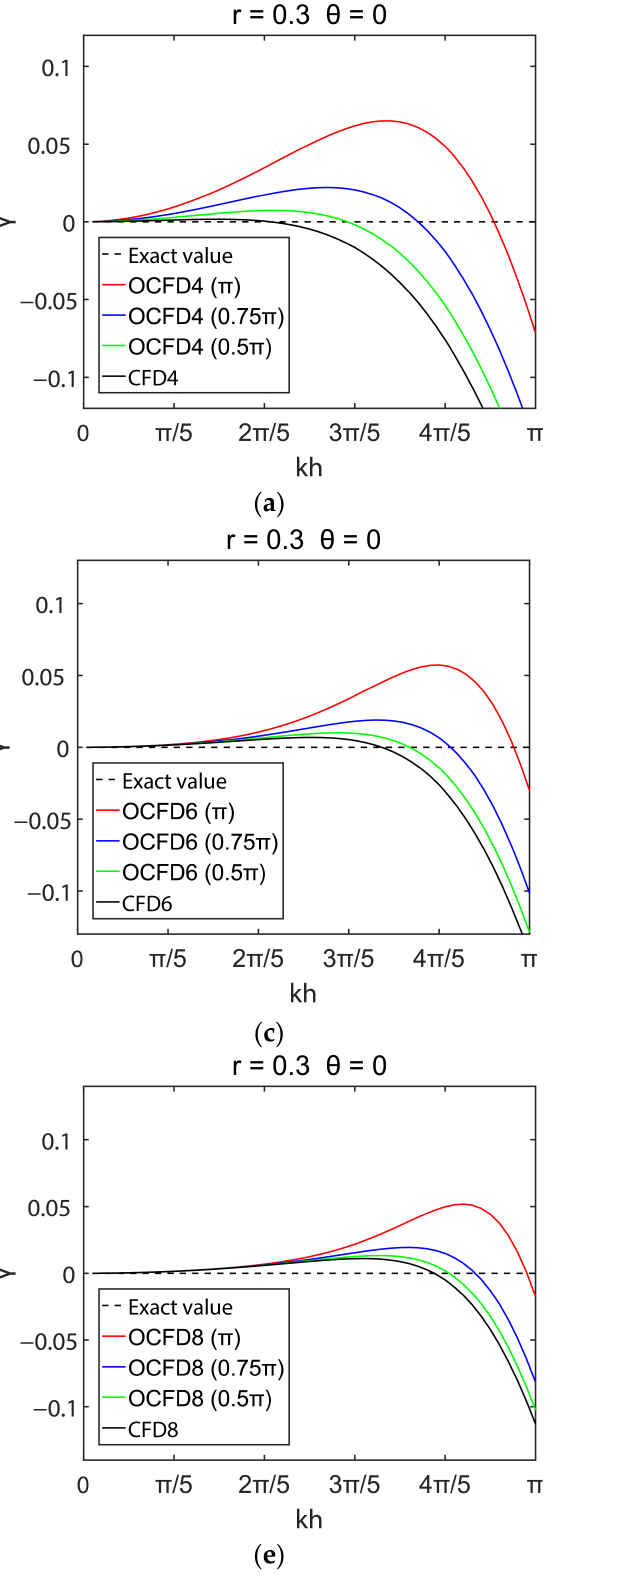
Figure 3. Dispersion curves of various r . ( a , b ) the CFD4 scheme and its optimization schemes, ( c , d ) the CFD6 scheme and its optimization schemes, ( e , f ) the CFD8 scheme and its optimization schemes.